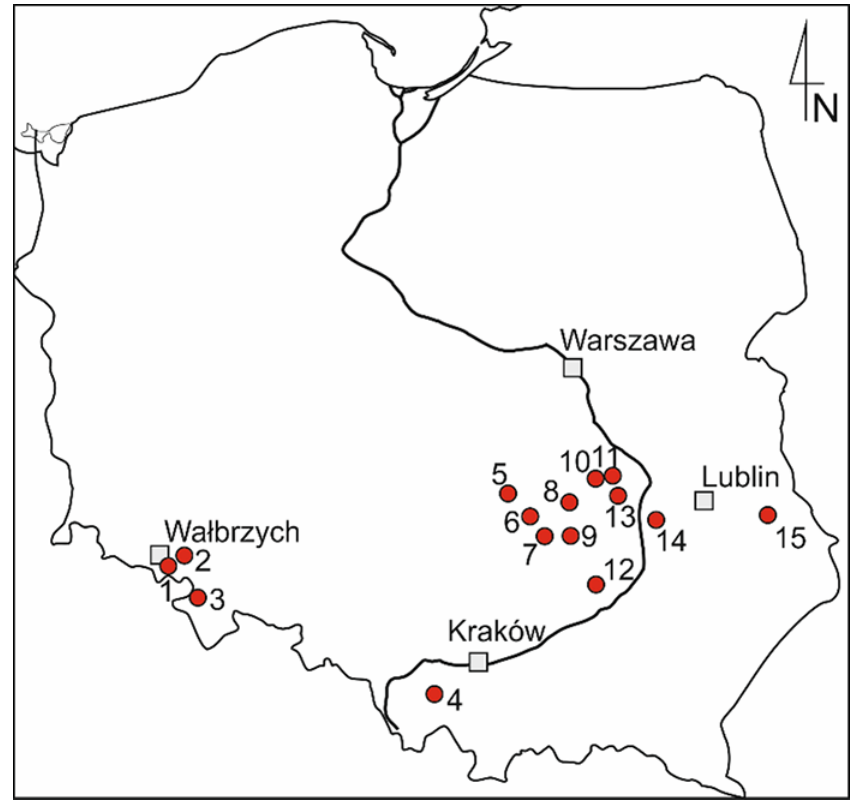
Figure 1 Plant macrofossil localities from the Polish Devonian: 1 –